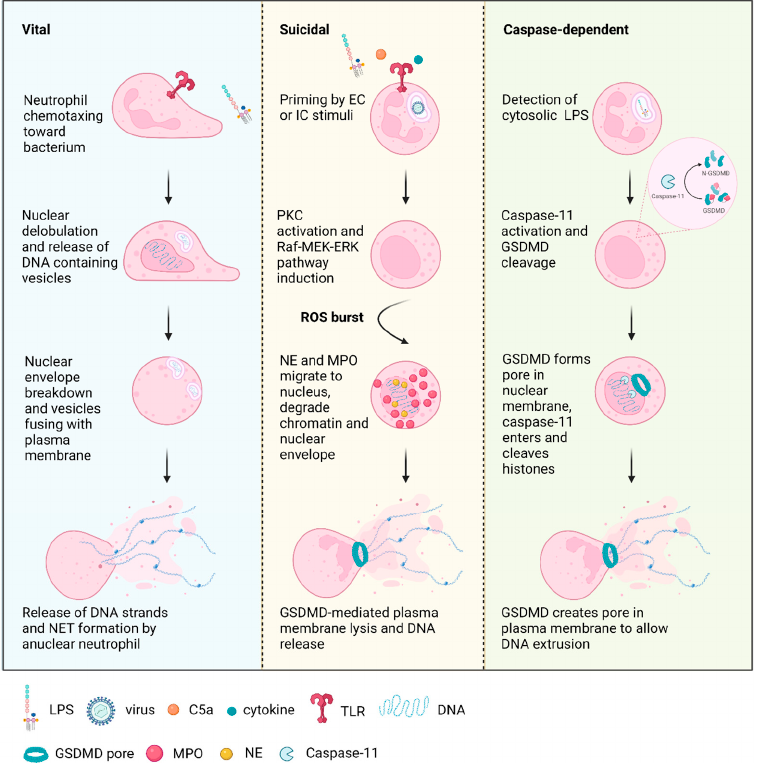
Figure 1. Types of neutrophil extracellular trap (NET) formation. Vital NETosis is initiated by the detection of Gram-positive or Gram-negative bacteria via Toll-like receptor 2 (TLR2) [65,66], with the neutrophil continuing to migrate toward the bacterium. This is followed by nuclear condensation and release of DNA containing vesicles, which fuse with the outer membrane and release their contents to the extracellular space to form NETs. Nuclear envelope breakdown occurs to form anuclear neutrophils. Priming of suicidal NETosis occurs with the detection of cytokines such as tumor necrosis factor α (TNF α ) and interleukin 8 (IL8) [5,67]; the complement component, C5a